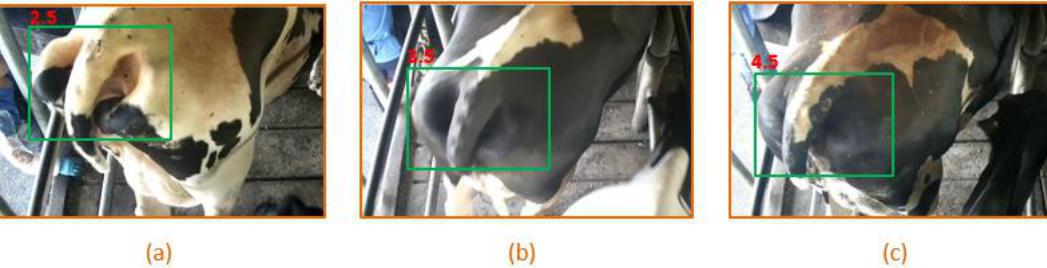
Figure 3. Image samples of cows back views, varying from different BCS values. The green boxes in the figures are labeled manually, we call the green box as ground-true box. ( a ) The value of BCS is 2.5; ( b ) The value of BCS is 3.5; ( c ) The value of BCS is 4.5.